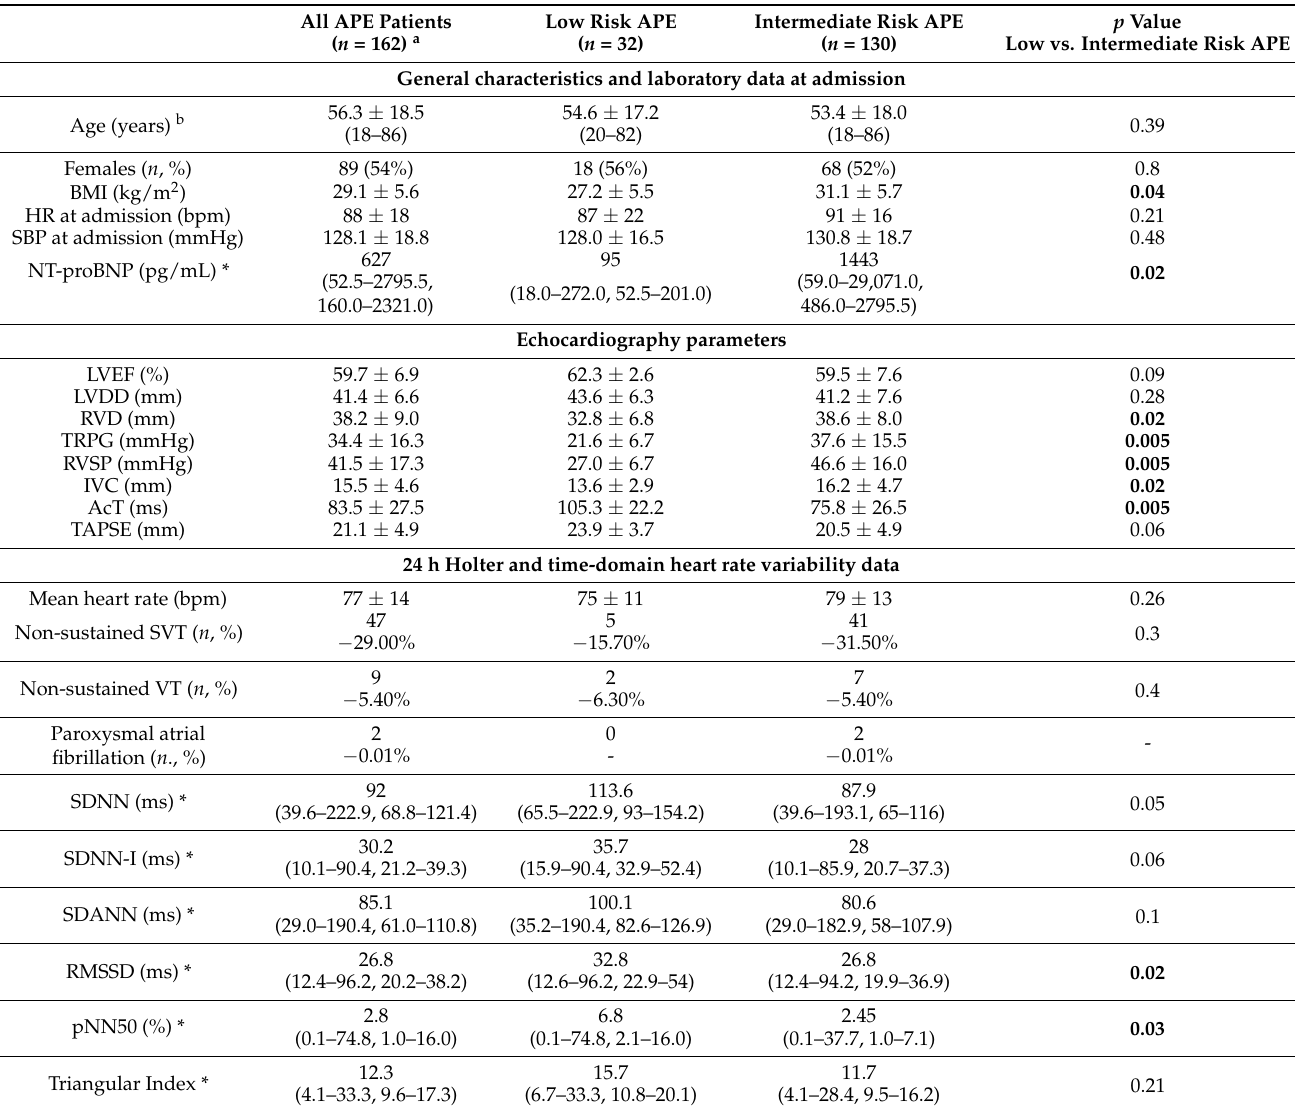
Table 1. The general characteristics, laboratory data, echocardiographic parameters and 24 h Holter and time-domain heart rate variability data in all enrolled patients with acute pulmonary embolism (APE), as well as in subgroups with low and intermediate early mortality